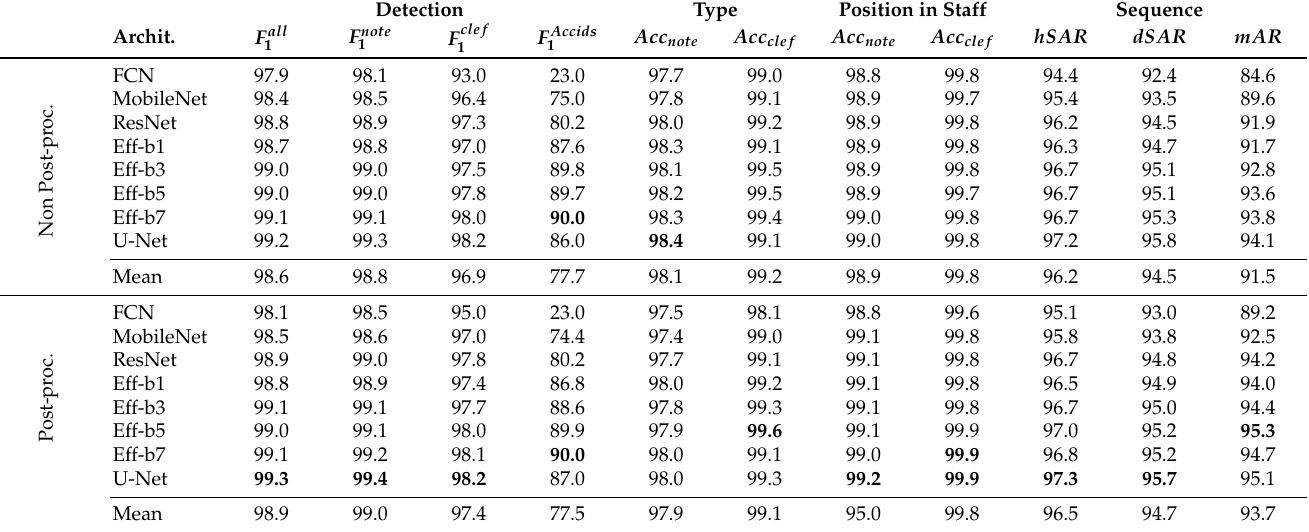
Table 4. Preliminary experiments for the symbol detection using different network architectures. All results are the averages of a five fold of each dataset part. The used backbone is stated on the left. The results of the detection accuracy of all symbols, of solely the notes and the clef, the type accuracy (Notes: looped, gapped, neume start; Clef: C-Clef, F-Clef), the position in staff accuracy of notes and clefs and the hSAR , dSAR and melody , given in percent are computed using all datasets except the Pa904. The bold numbers highlight the best value for each